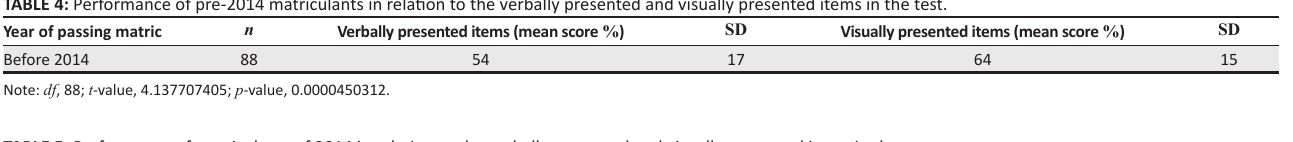
TABLE 5: Performance of matriculants of 2014 in relation to the verbally presented and visually presented items in the test. Year of passing matric n Verbally presented items (mean score % ) SD Visually presented items (mean score % ) SD